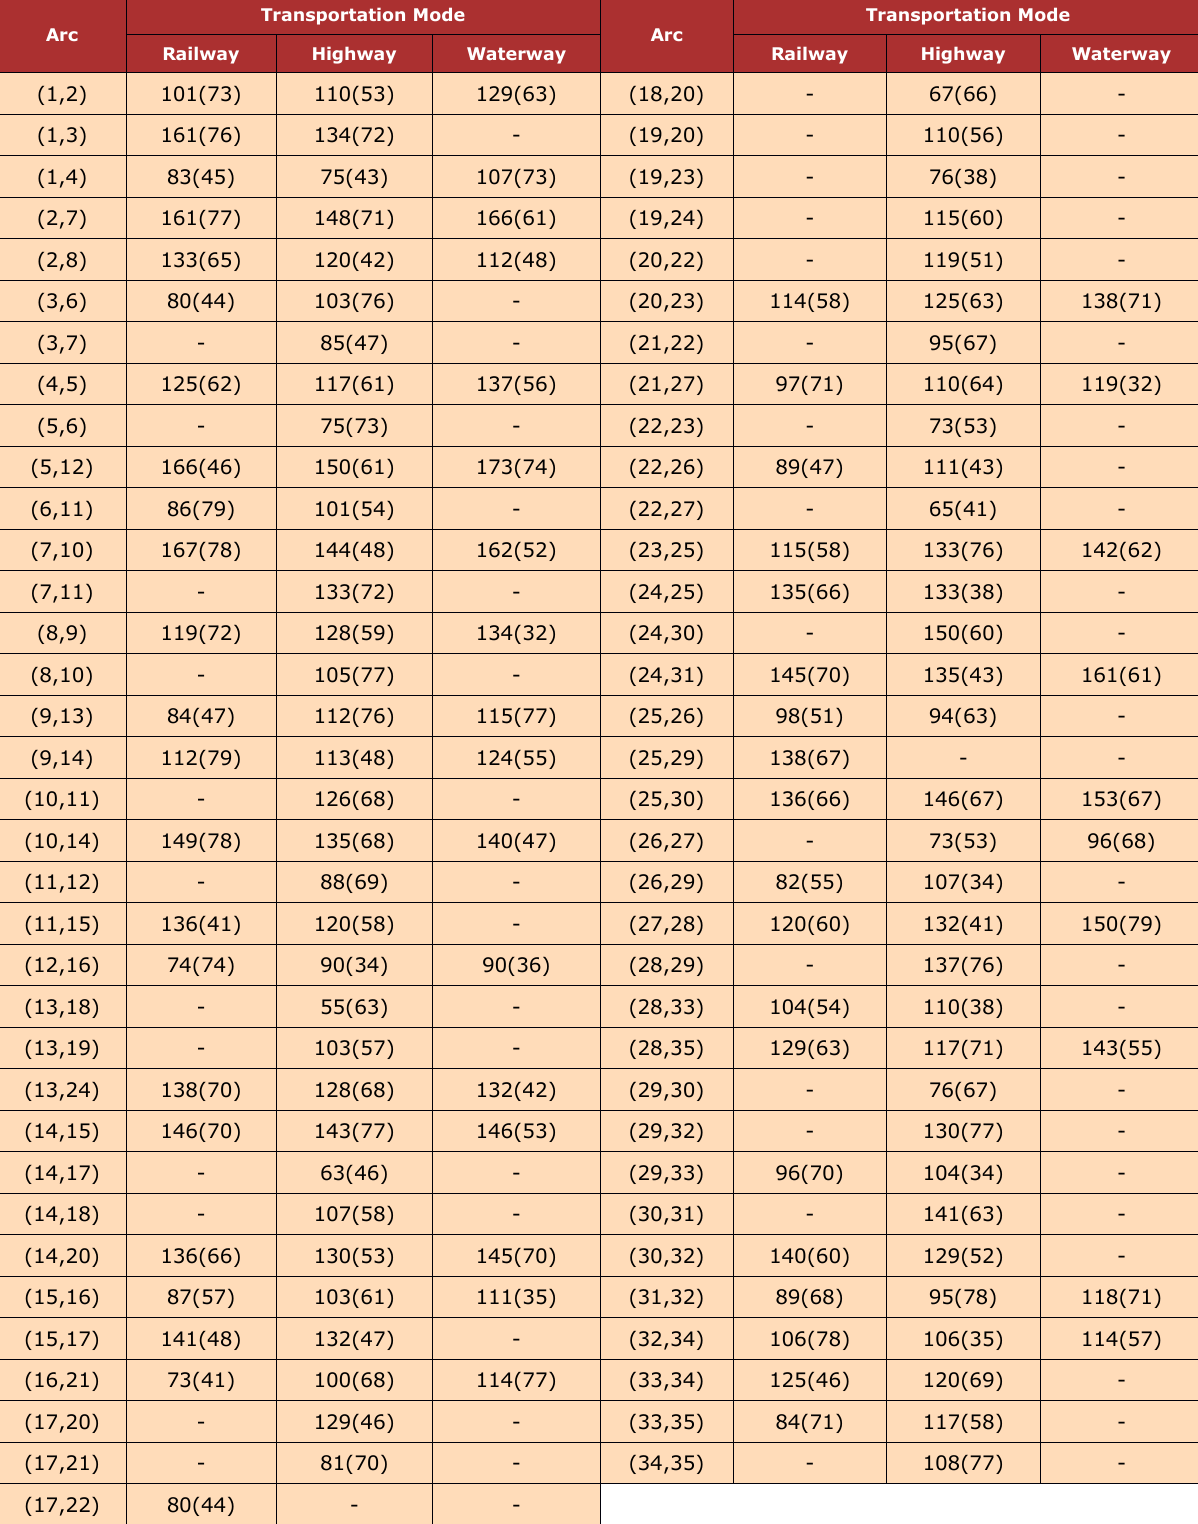
Table 4. Transportation distances and capacities of the